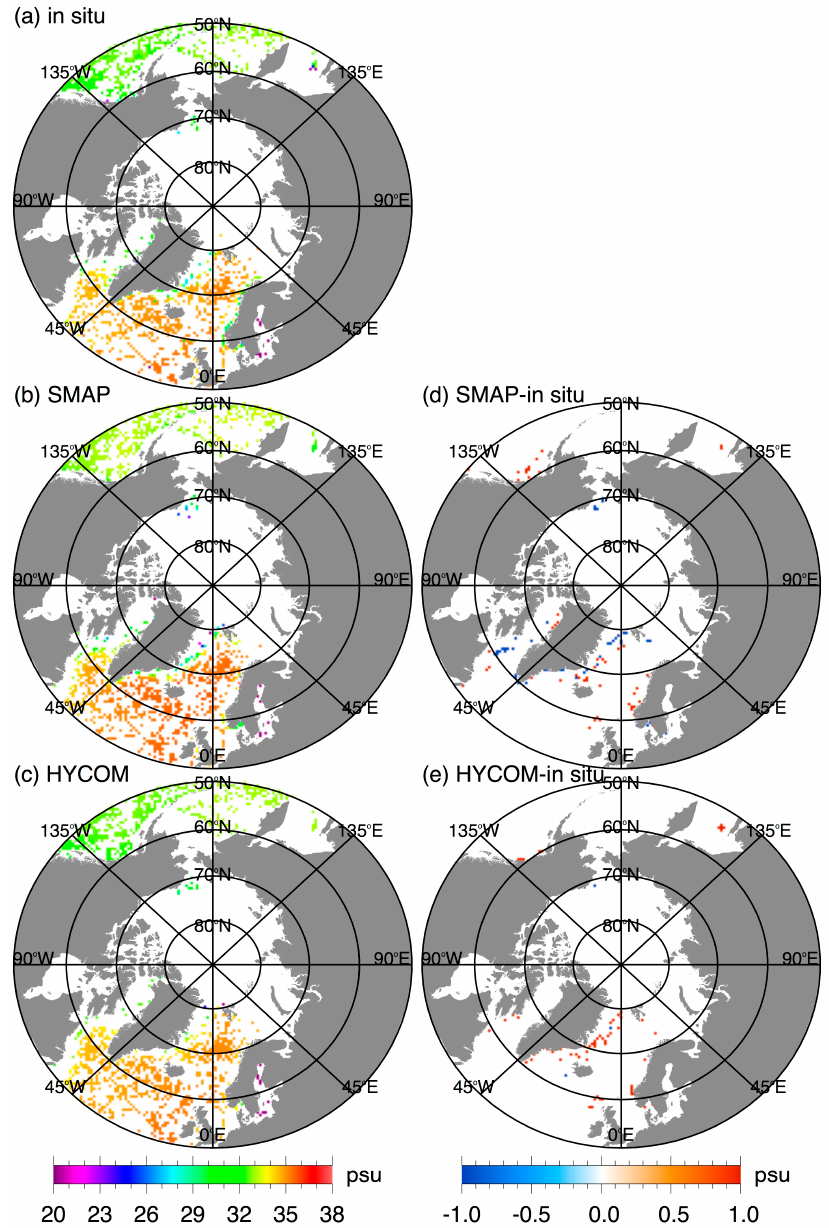
Figure 2. Salinity maps North of 50 ◦ N averaged from 1 April 2015 to 31 March 2018 from ( a ) in situ data, ( b ) Soil Moisture Active Passive Sea Surface Salinity (SMAP SSS), and ( c ) Hybrid Coordinate Ocean Model (HYCOM) SSS, and the difference of ( d ) SMAP SSS minus in situ, and ( e ) HYCOM SSS minus in situ, wherever absolute differences less than 1 psu are masked out in white.